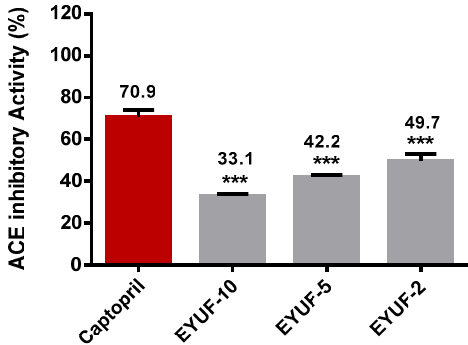
Figure 5. ACE inhibitory activity (%) of hydrolyzed and fractionated egg yolk protein. The activity (%) of 10 mg/mL EYUF-10, EYUF-5 and EYUF-2 to inhibit ACE was measured by HPLC and is shown at the top of the bars. Captopril (0.5 mg/mL), shown in red, was used as a positive control. Data correspond to the means ± SD of three independent experiments. ANOVA was performed in Graphpad Prism version 6.0, followed by Dunnett’s multiple comparisons test. The result was considered statistically significant versus captopril ( *** = p < 0.001).